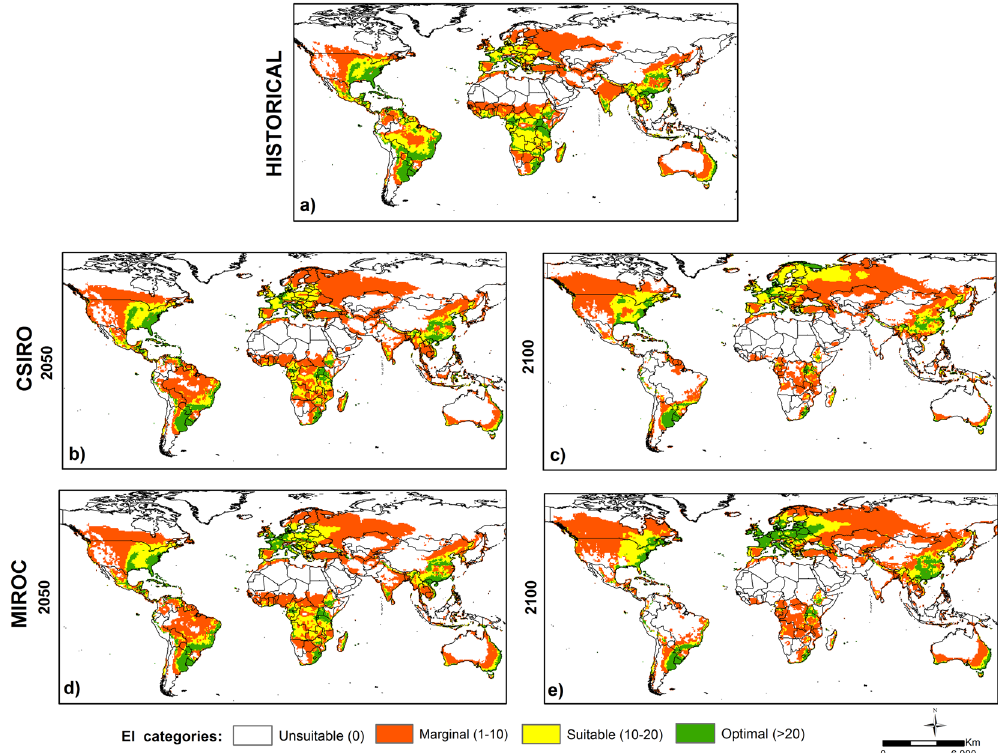
Figure 2. The Ecoclimatic Index (EI) of future climate conditions for maize ( Zea mays L.) under the SRES A2 (resembling RCP 8.5) in CSIRO: ( a ) Historical ( b ) in 2050 ( c ) in 2100; and in MIROC ( d ) in 2050 ( e ) in 2100. ArcMap 10.2